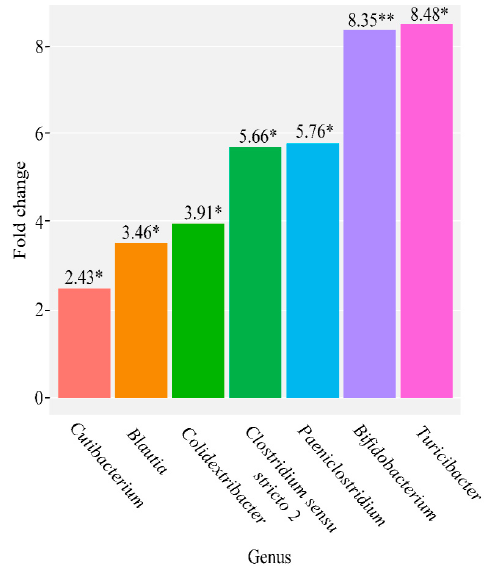
Figure 2. Quantitative changes in the general composition of the microbiome of milk samples taken from cows with acute catarrhal mastitis, compared to the control group ( ∗ p ≤ 0.01, ∗∗ p ≤ 0.001). In the group of cows with subclinical mastitis, there is a significant increase in only one genus Staphylococcus of 7.42 times ( p = 0.0005), compared to the control group. We have observed an increase in the genera Microbacterium of 5.75 times ( p = 0.0004) and Staphylococcus of 7.09 times ( p = 0.0005) in the group of cows with pathology, when comparing the microbiome composition between the groups of cows with udder irrita- tion and the control group (Figure 3). Figure 3. Quantitative changes in the general microbiome composition of milk samples taken from cows with udder irritation compared to the control group ( ∗∗ p ≤ 0.001).